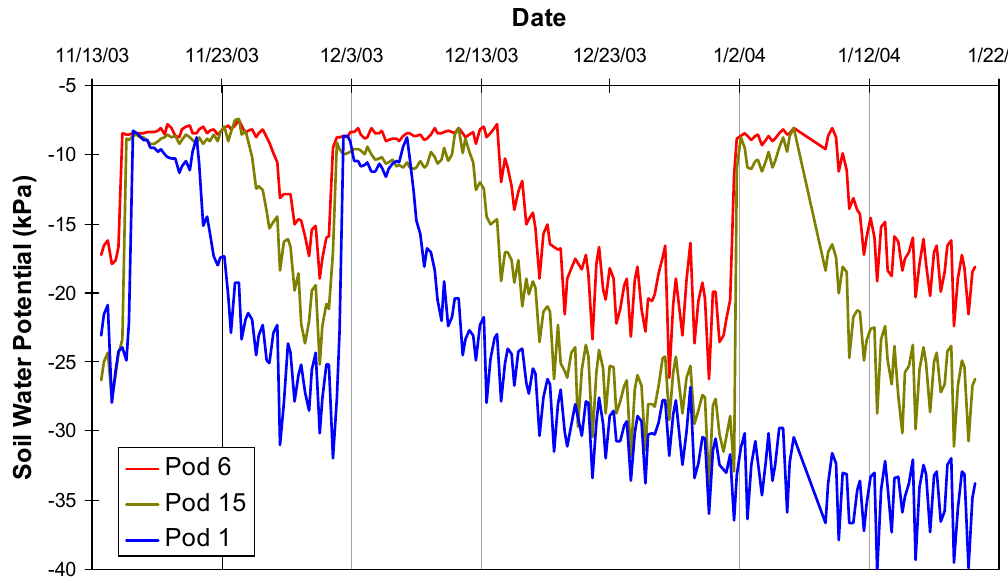
Figure 9. Soil water potential at 0.5 m deep along the west basin border. Note that the third flooding event did not last long enough to affect pod 1.